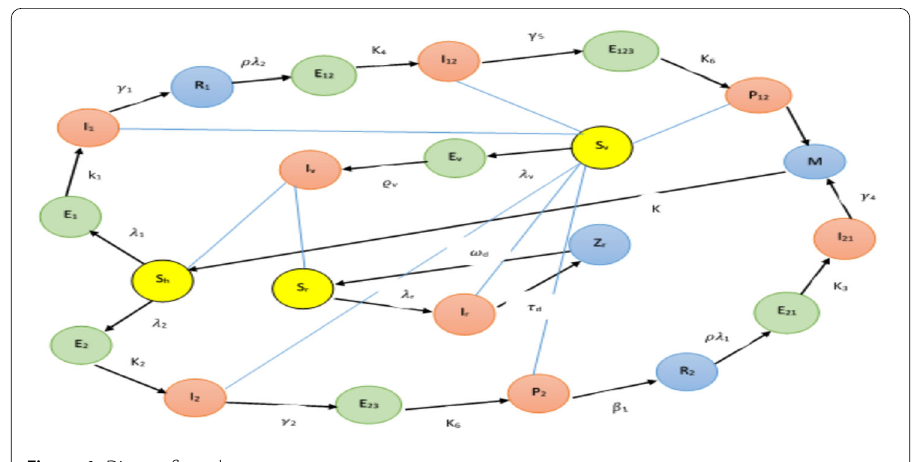
Figure 1 Disease flow